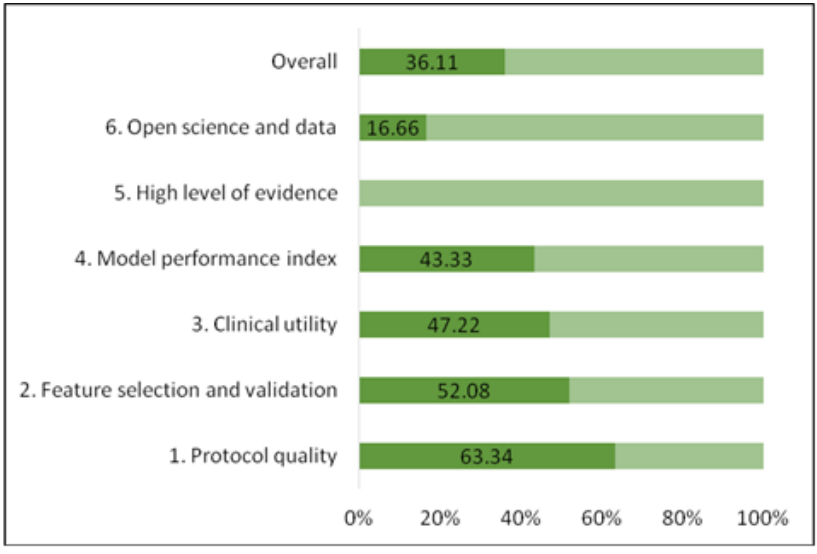
Figure 2. Adherence rate of the RQS of the included studies according to RQS key domains.